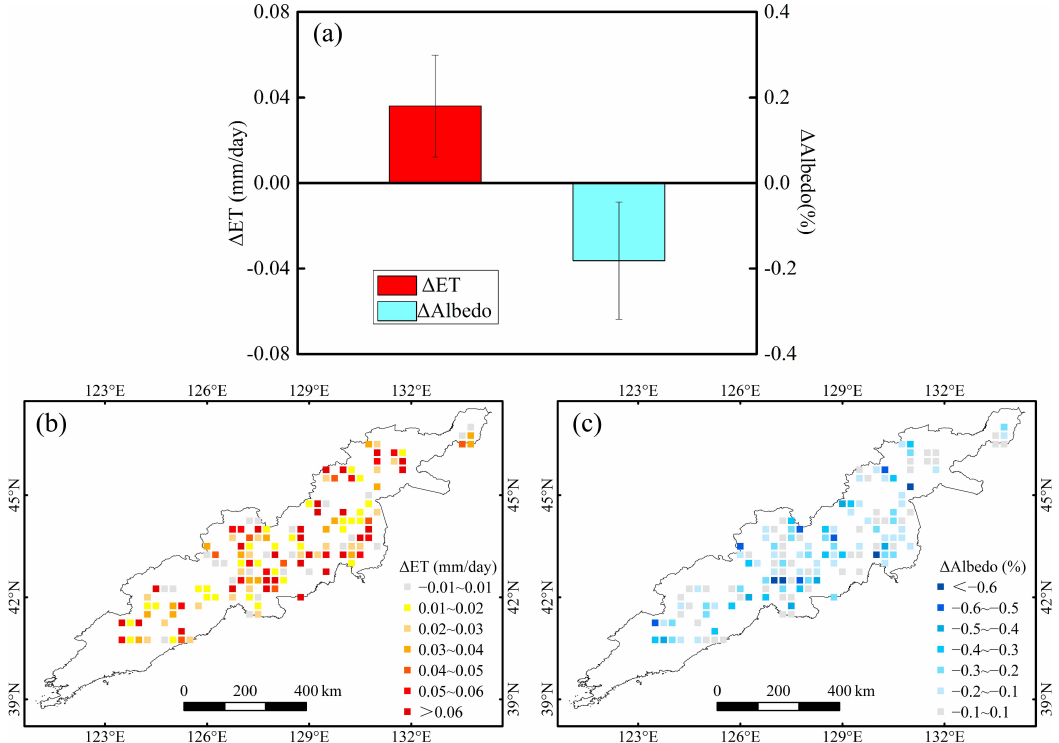
Figure 6. Average value ( a ) and spatial distribution of differences in summer evapotranspiration ( ∆ ET, mm/day) ( b ) and albedo ( ∆ Albedo, %) ( c ) between high- and low-coverage forest in Changbai Mountain from 2003 to